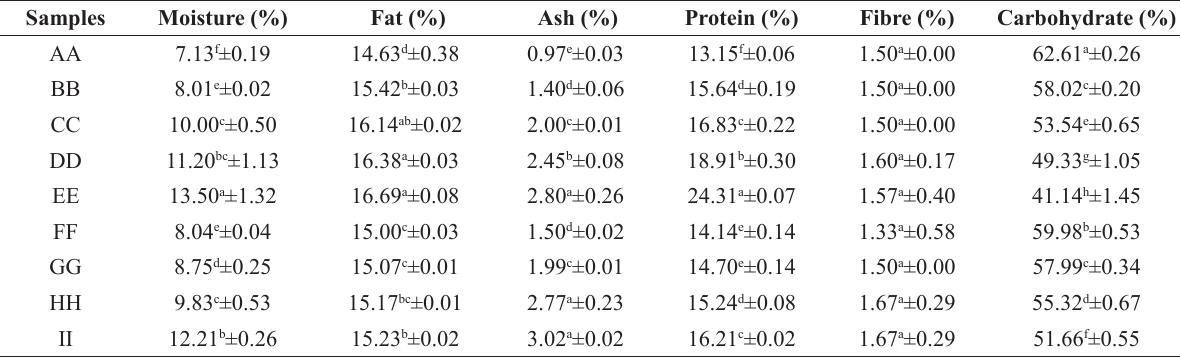
Table 2: Proximate Composition of the snacks of different blends of maize and groundnut.